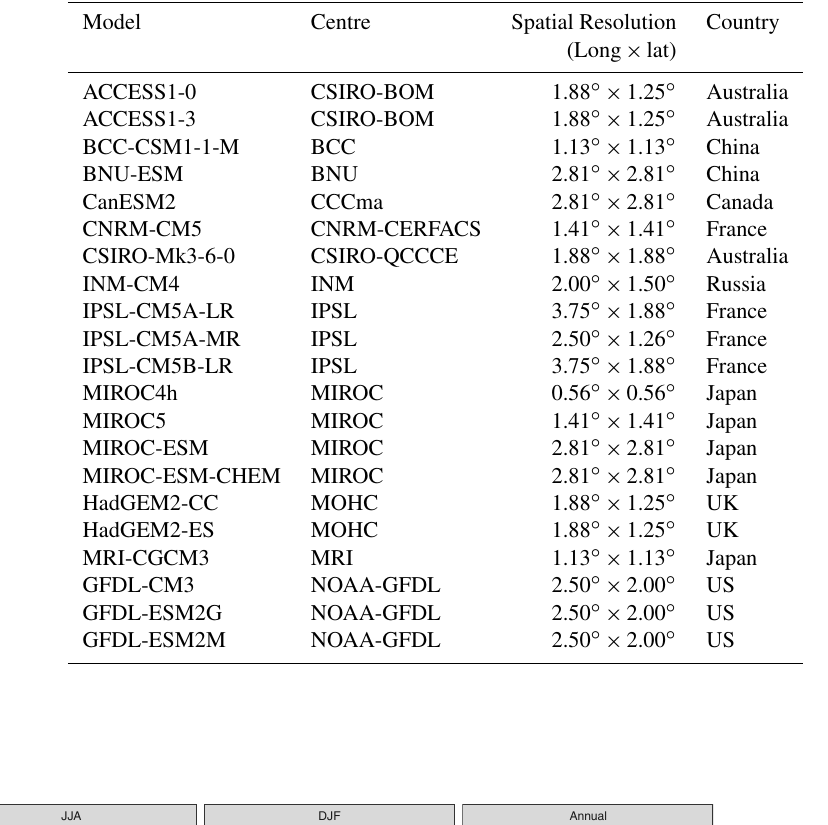
Table A1. CMIP5 model output used and data resolution.